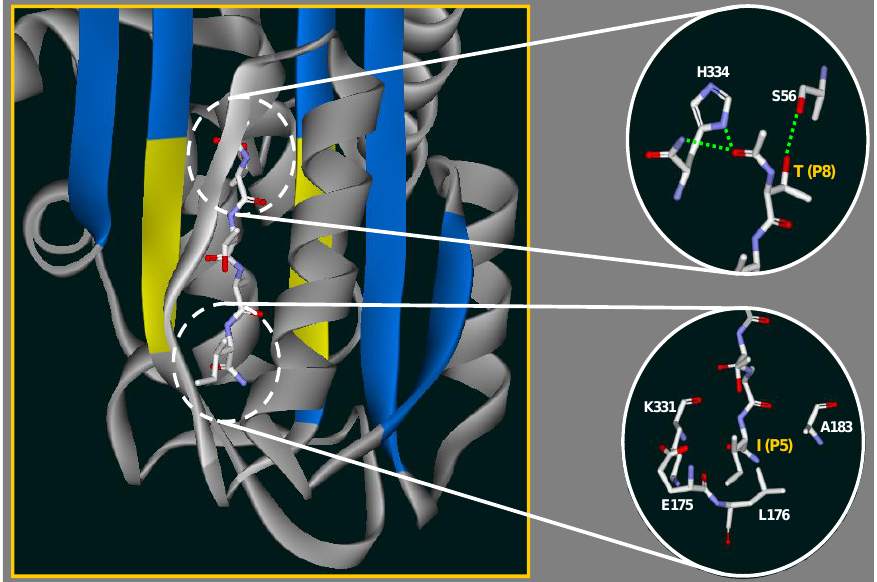
Figure 9. Proposed structure of Ac-TTAI-NH binding to α -antitrypsin (AT). The peptide 2 1 inserts into the β-sheet (labeled in blue) of AT and interacts with its nearby residues. The NH and CO groups from the backbone of incorporated peptide are hydrogen bonded to the backbones of adjacent strands (resides in yellow) of AT and render the β-sheet into a 6-stranded antiparallel β-sheet. The circle panel on the upper right reveals the hydrogen bond (light green dashed line) between the N-terminal theronine of Ac-TTAI-NH and 2 Ser56. Additional hydrogen bonds derive from the acetyl group of peptide with His334 (light green dashed line) and its backbone NH group (light green dashed line) are also illustrated. The other circle panel on the lower right shows the hydrophobic side chain of isoleucine occupies a pocket surrounding by residues K331, E175, L176 and Ala183. Carbon, nitrogen and oxygen atoms are shown in white, light blue and red,